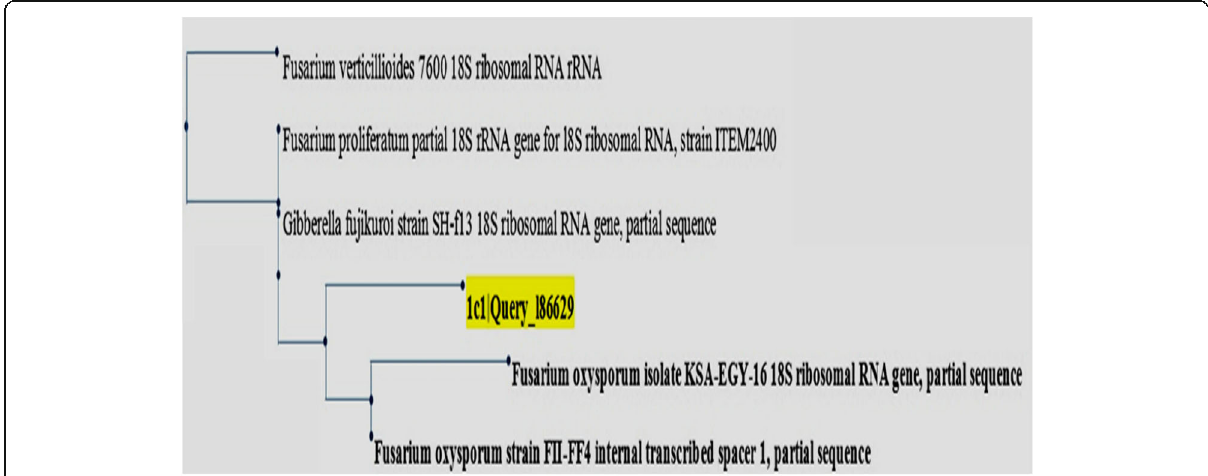
Fig. 2 Phylogenetic tree showing the relationships among the selected isolate F. oxysporum NRC 2017 and other closely related sequences collected from the GeneBank